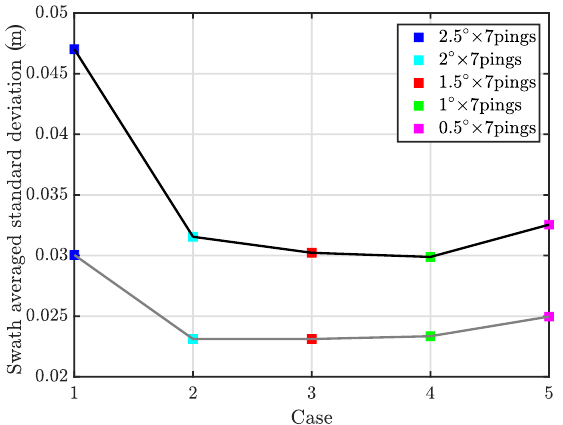
Figure 2. Mean value of the vertical uncertainty for different patch sizes in the across-track direction (squares with varying colors) for a water depth of 10m (gray line) and 30m (black line) and a pulse length of